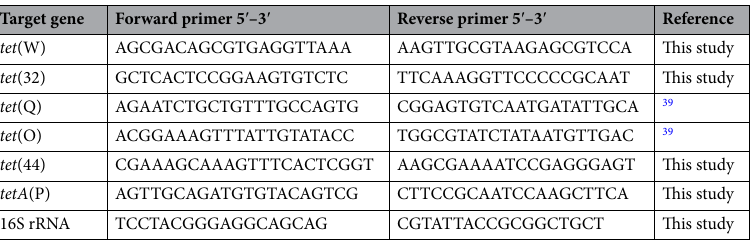
Table 2. List of primers used in this